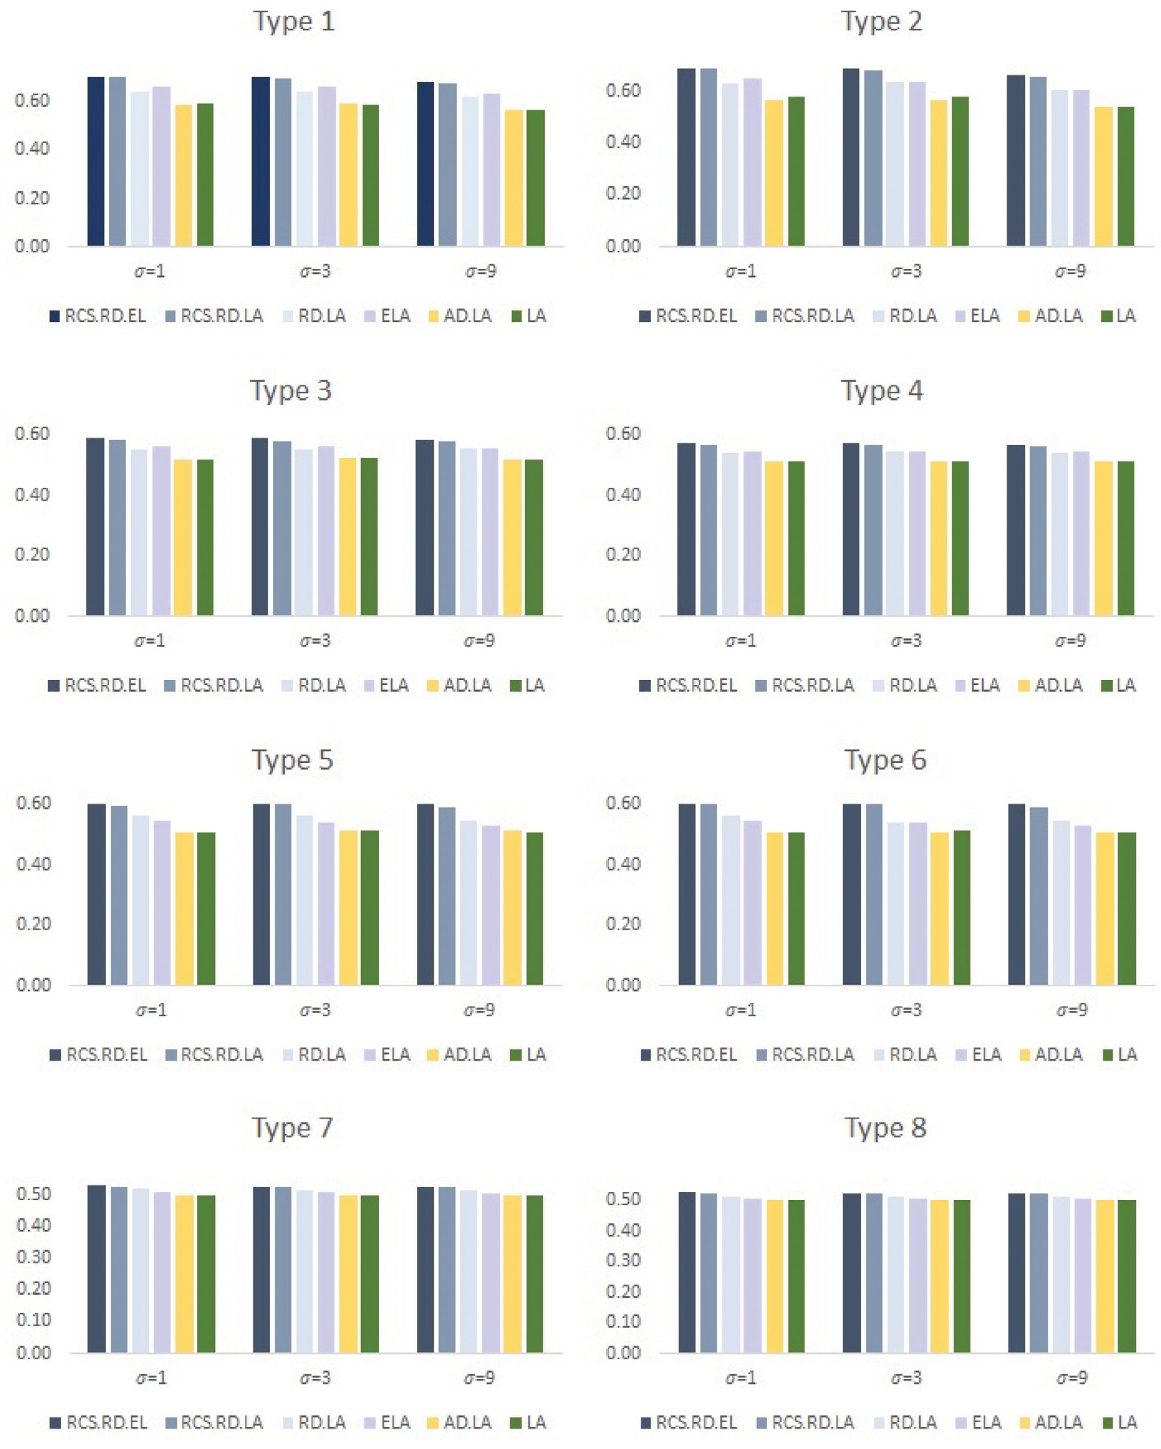
Fig 2. Variable selection results: Average of T.P and T.N.